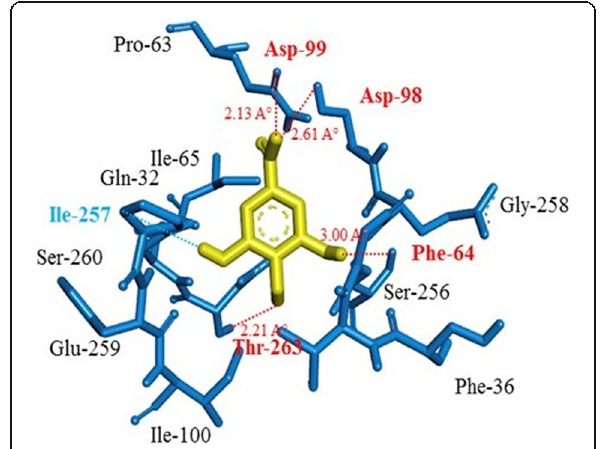
Fig. 5 Docking complexes of gallic acid-Bcl2-associated X (BAX) protein